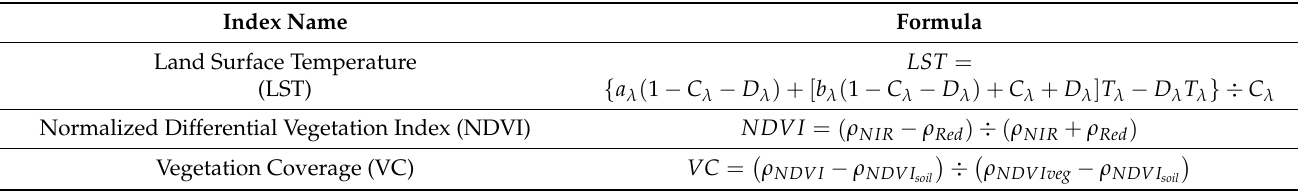
Table 1. The formulae for different indexes.